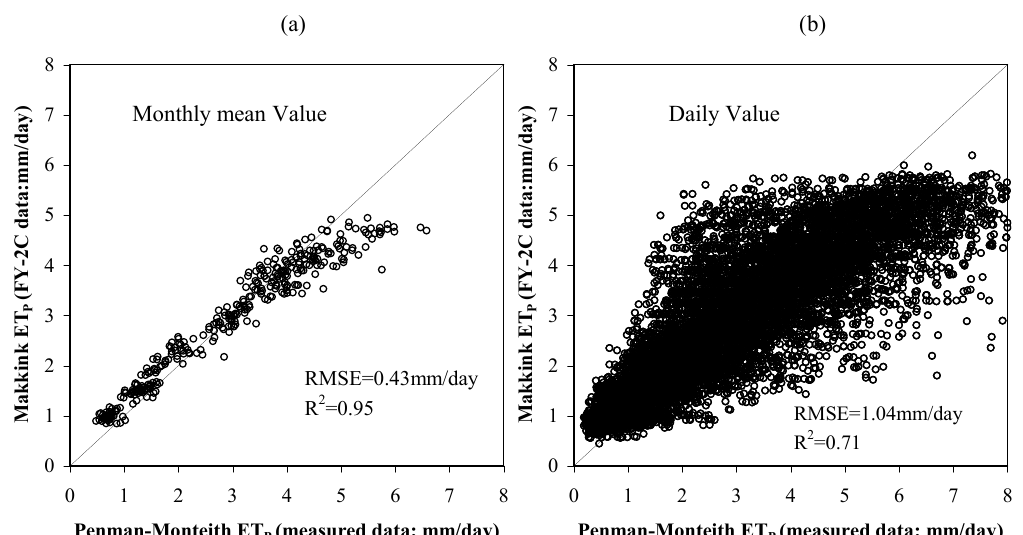
Figure 8. Comparison of ET p calculated by the Penman-Monteith equation on the basis of measured meteorological data and the Makkink equation based on the FY-2C incoming solar radiation product. ( a ) monthly mean values, ( b ) daily mean values for the period June 2005 to August 2008.